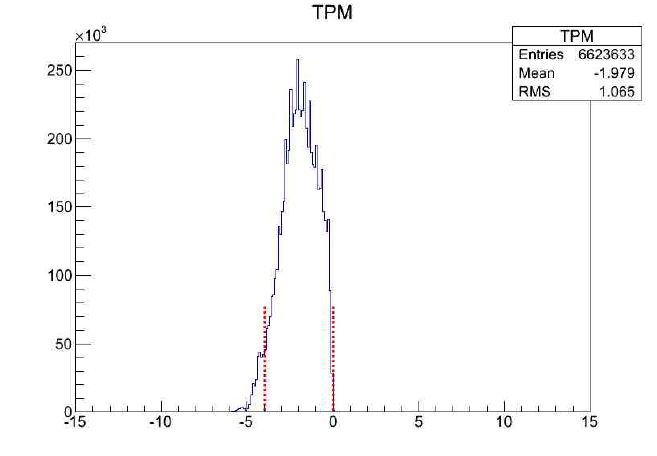
Figure 2. Distribution of the beam-target interaction point. The vertical lines represent the criteria to select the dp -elastic scattering